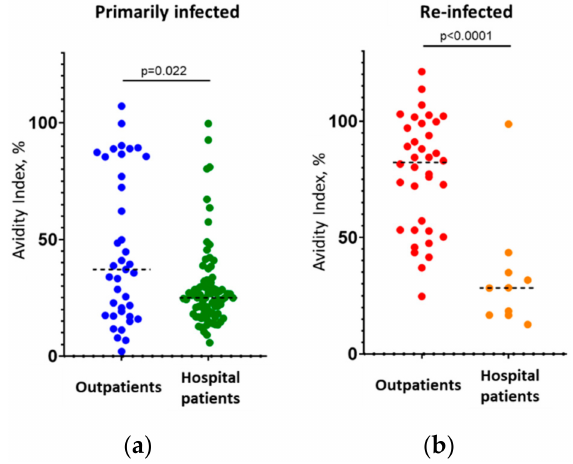
Figure 2. Comparison of AI values in primarily infected ( a ) and reinfected ( b ) COVID-19 patients with mild and severe disease. Notation is the same as that in Figure